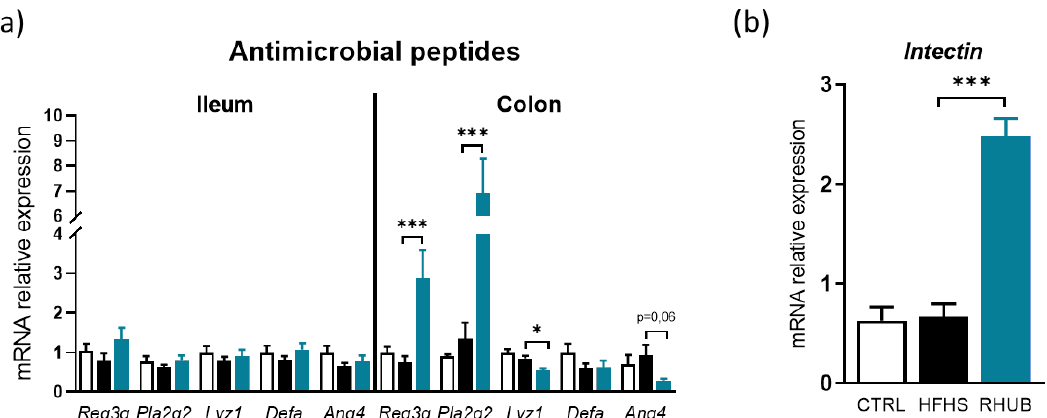
Figure 3. Rhubarb root extract protects against adiposity and adipose tissue inflammation ( a ) Adipose tissue weights (mg) measured after 8 weeks of experiment. SAT, subcutaneous adipose tissue, EAT, epididymal adipose tissue, VAT, visceral adipose tissue. White adipose tissue index measuring by adding all adipose tissue weights. ( b ) Representative adipose tissue Hematoxylin and Eosin staining. Scale bar, 25 µM. ( c ) Adipocyte size (µm 3 ). ( d ) Representative adipose tissue F4/80 immunohistological staining. Scale bar, 25 µM. ( e ) Counting of the F4/80 positive area. ( f ) mRNA expression of different inflammatory markers in the adipose tissue. ( g ) Brown adipose tissue weight (mg) measured after 8 weeks of experiment. ( h ) mRNA expression of Ucp1 in the brown adipose tissue. ( i ) Brown adipose tissue citrate synthase activity (µmol/mg BAT/sec) and correlation between brown adipose tissue weight and citrate synthase activity. p-value and R 2 come from linear regression. White, CTRL fed mice; Black, HFHS fed mice and Blue, HFHS fed mice supplemented with rhubarb. Data represent mean ± SEM. * p ≤ 0.05, ** p ≤ 0.01, *** p ≤ 0.005. WAT, White adipose tissue, BAT, Brown adi pose tissue, CS, citrate synthase.